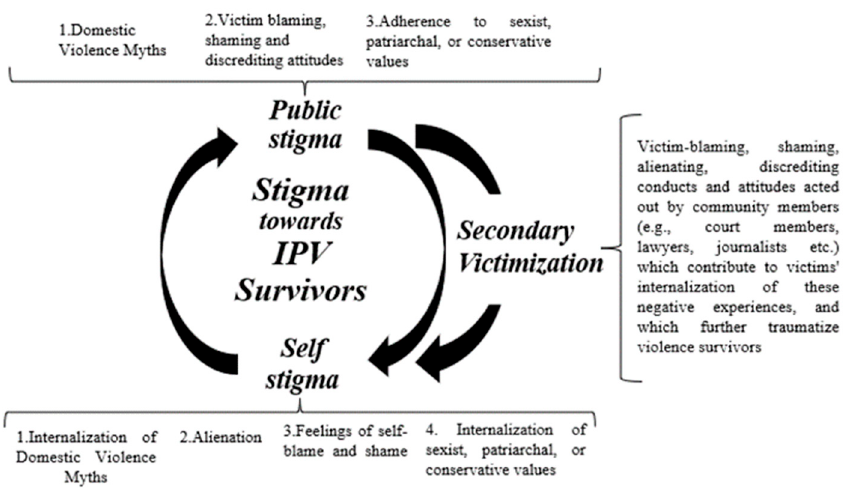
Figure 2. Definition of stigma towards IPV survivors.